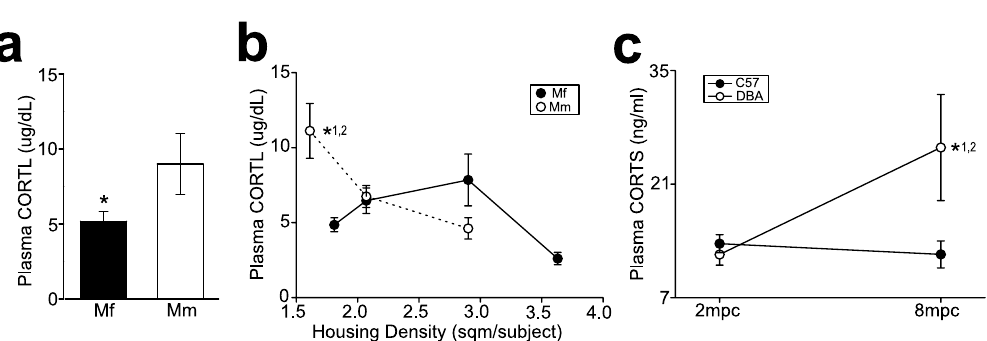
Figure 4. Plasma monoamine concentrations and monoamine availability in corticolimbic regions of group- housed mice. ( a ) A graph showing plasma 5-HT concentrations in C57 and DBA mice under 2 mpc and 8 mpc. * 1 p = 0.008 for C57 vs. DBA under 2 mpc, * 2 p = 0.044 for C57 vs. DBA under 8 mpc. ( b ) A graph showing tissue 5-HT concentrations (5-HT availability) in mesocorticolimbic regions of C57 and DBA mice under 2 mpc and 8 mpc. * 1 p = 0.006 for C57 vs. DBA in PFC, * 2 p = 0.016 for C57 vs. DBA in dSTR. ( c ) A graph showing the ratio of 5-HT availability in each brain region for 8 mpc over 2 mpc conditions. * p = 0.001. ( d ) A graph similar to ( a ), but showing plasma DA concentrations. ( e , f ) Graphs similar to ( b ) and ( c ), but showing DA availability. * 1,2 p < 0.001.